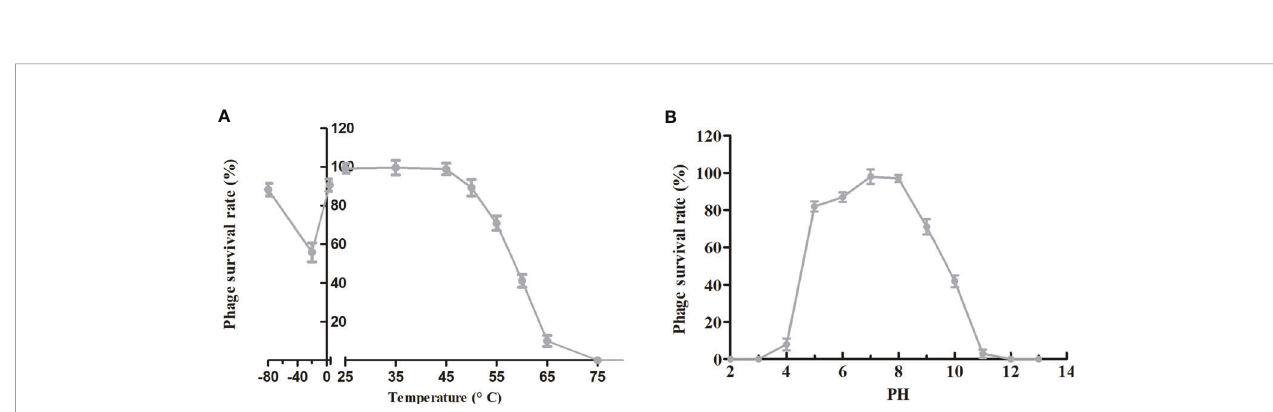
FIGURE 4 | In vitro characterization of phage PAJD-1. (A) One-step growth curves and (B) adsorption rates of PAJD-1. Results are shown as means ± SEM from triplicate experiments.